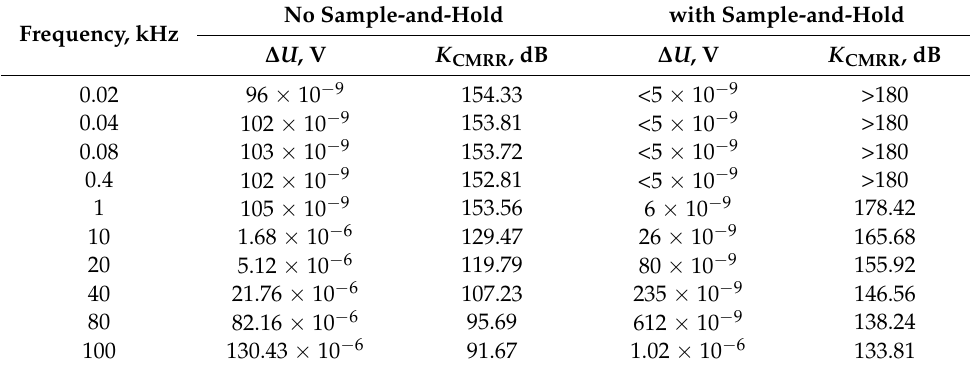
Table 3. CMRR of the lock-in amplifier.